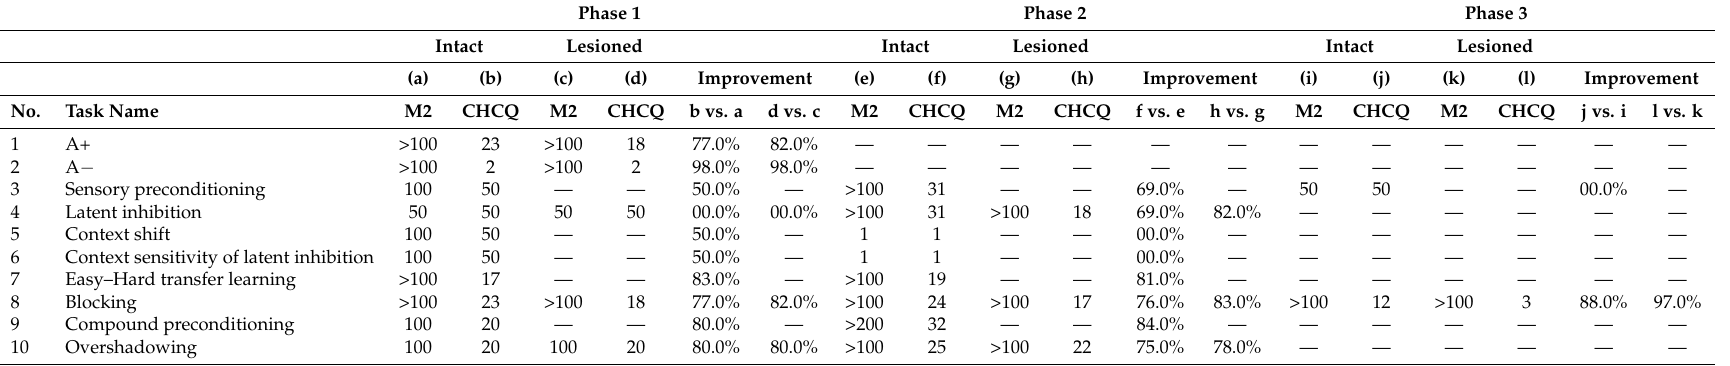
Table 3. A comparison between M2 (Moustafa et al. model) and the CHCQ model, in terms of trial numbers needed to get the final state of